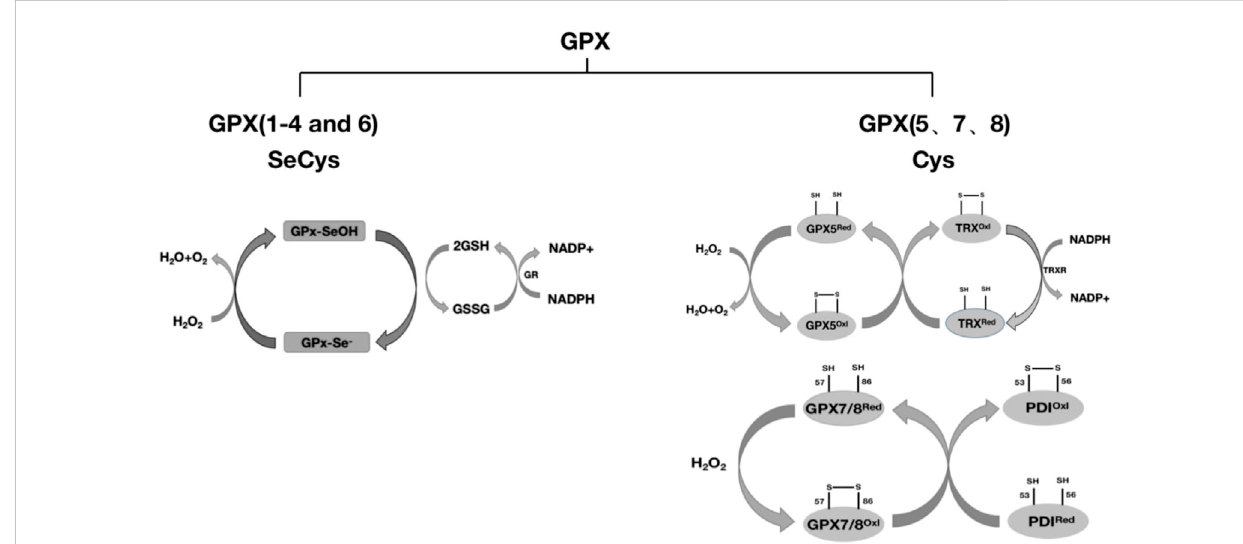
FIGURE 8 Classi fi cation of GPX and redox reactions. GPX1-4 and GPX6 reduce H 2 O 2 with the assistance of glutathione (GSH), and whether GPX6 passes through this pathway remains to be further studied. GPX5 requires the reduction of H 2 O 2 with the assistance of TRX. GPX7 and GPX8 require the reduction of H 2 O 2 through the protein oxidative folding process with theparticipation of thechaperone protein PDI. The detailedprocess isdescribed in this article.